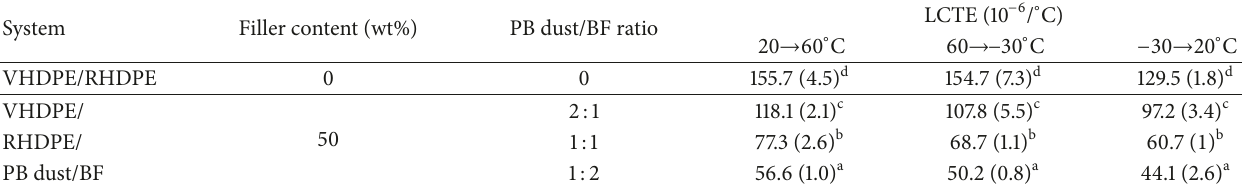
Table 4: Thermal expansion properties of HDPE and filled HDPE composites with combined fillers. System Filler content